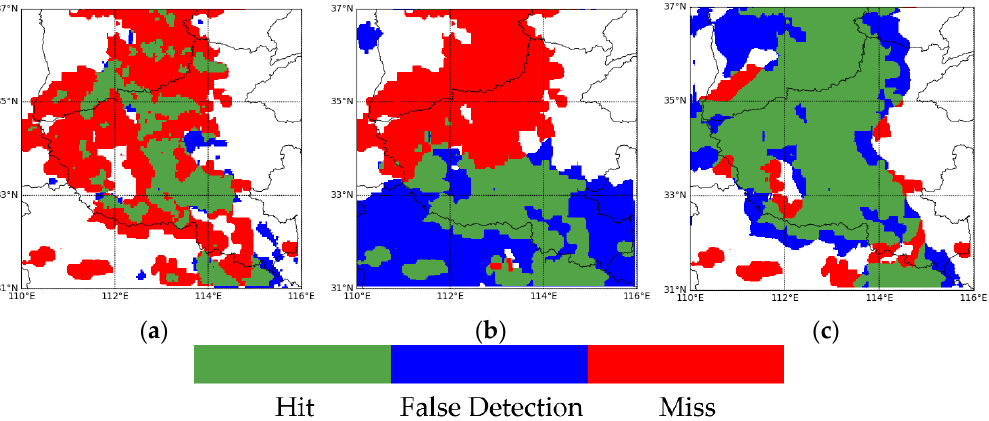
Figure 5. Visualization of precipitation identification performance of CMORPH, FY4A-QPE and Attention-Unet model over the Henan province at 0430 UTC 19 July 2021. ( a ) FY4A-QPE; ( b ) CMORPH; ( c ) Attention-Unet.